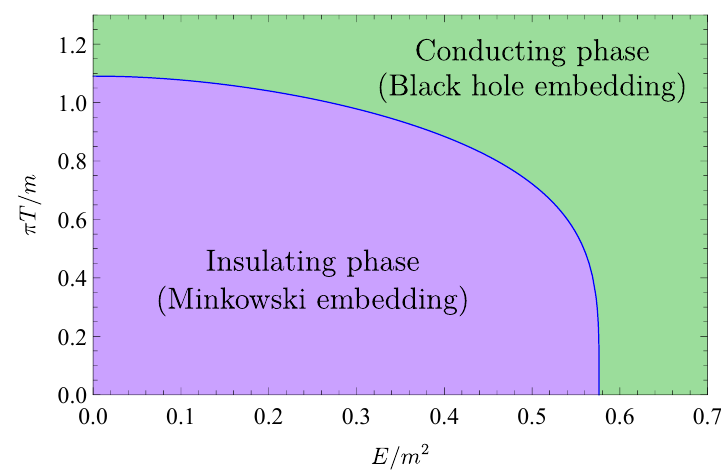
Figure 2 . The phase diagram of the D3-D7 model in the electric field and temperature plane. The solid blue curve denotes the boundary between the black hole embedding (green region) and Minkowski embedding (purple region), which is called the critical embedding. These two embeddings correspond to the conducting phase and insulating phase in the dual field theory,